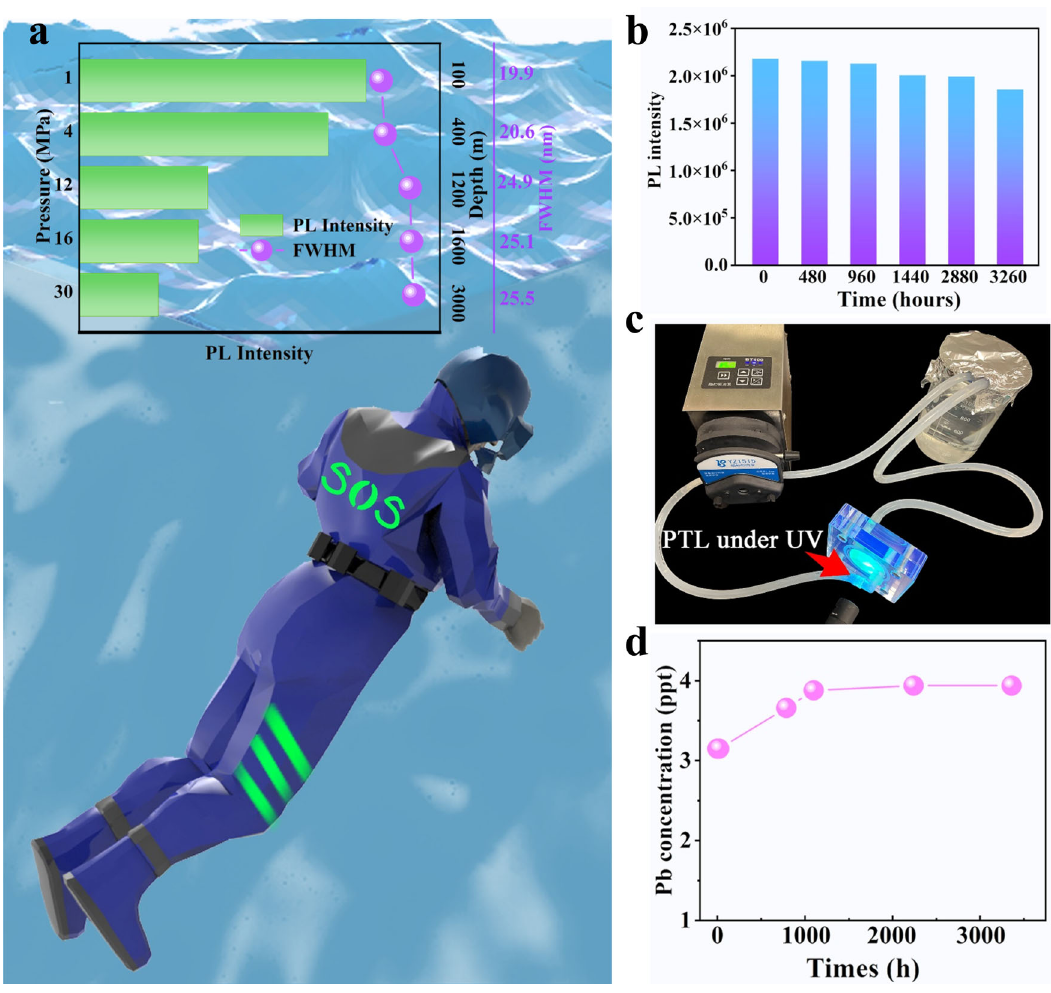
Fig. 5 | Demonstration of PLT in marine rescue. a The evolution of PL intensity and FWHM of CsPbBr 3 @HPbCD@PFOS-based PLTs as a function of pressure and depth,andtheschematicimageofan “ SOS ” signalpatternedonthelifejacketmade by CsPbBr 3 @HPbCD@PFOS fi ber. b The evolution of PL intensity of